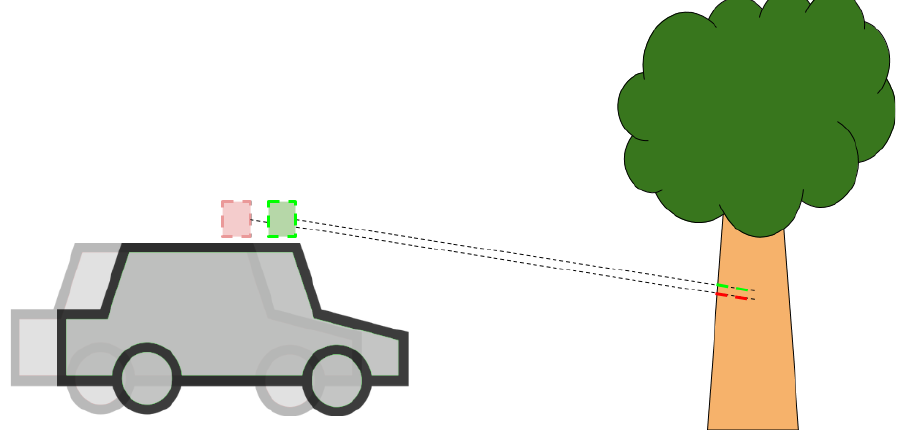
Figure 2. As the vehicle moves, a 3D point cloud of the surroundings can be constructed using the 2D laser scanner distance data in combination with the position and the orientation of the